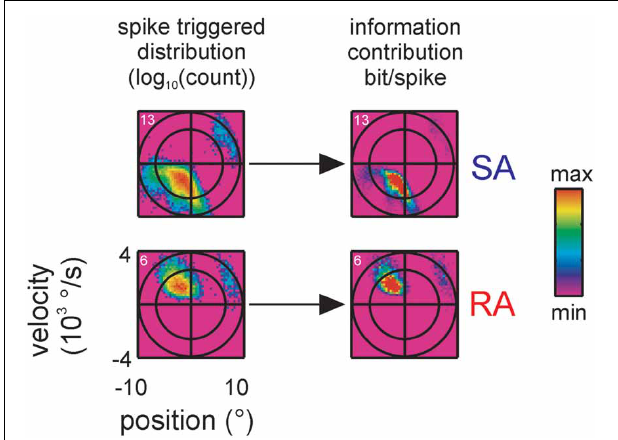
FIGURE 5 | Information contribution of extra lobes. Encoded stimulus features of two representative primary afferents containing multiple lobes, one SA (top, cell #13) and one RA (bottom, cell #6), are shown (conventions for axes and ellipsoid as in Figure 3 ). On the left, the spike triggered stimulus distributions are re-plotted from Figure 4 for comparison. On the right the information contribution of each stimulus bin is plotted (term within the sum operator in Equation 4). Information contribution of the extra lobe scales with the spike triggered distribution indicating that the sensitivity of the extra lobe does not grossly deviate from the one of the main